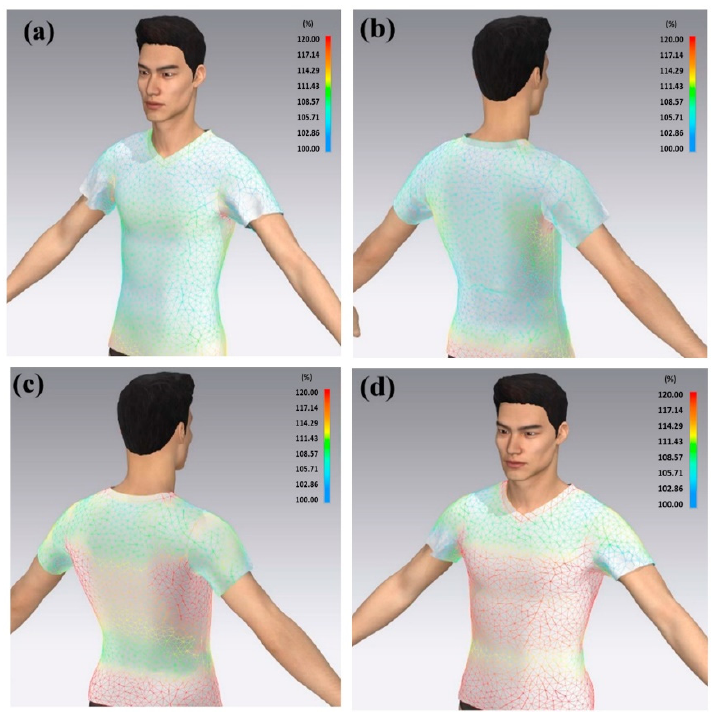
Figure 14. Tension simulation during breathing process. ( a ) Exhale—front view, ( b ) exhale—back view, ( c ) inhale—back view, and ( d ) inhale—front view. Colour scale shows the expansion of